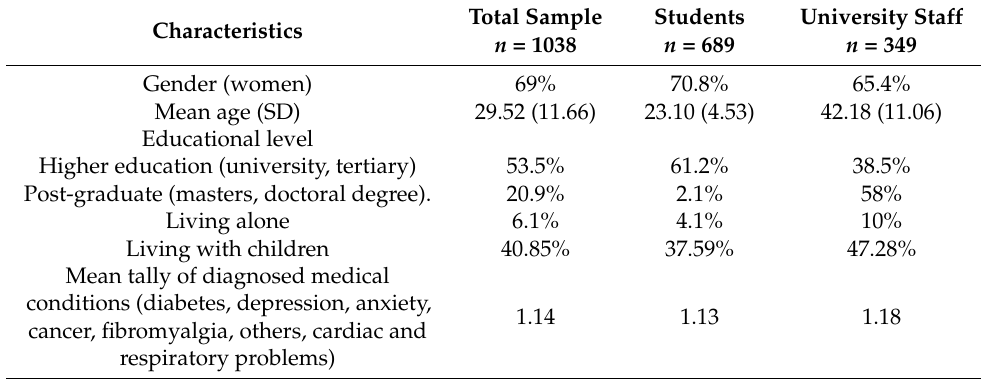
Table 1. Sociodemographic characteristics of participants at W1 ( n =